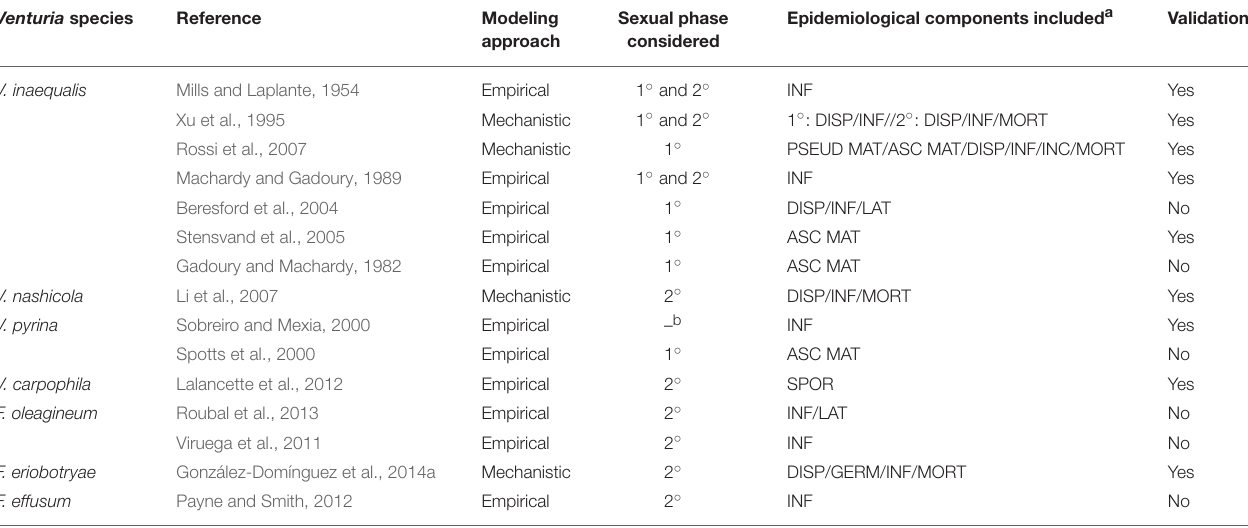
TABLE 7 | Characteristics of the epidemiological models developed for the Venturia spp. considered in this review. Venturia species Reference